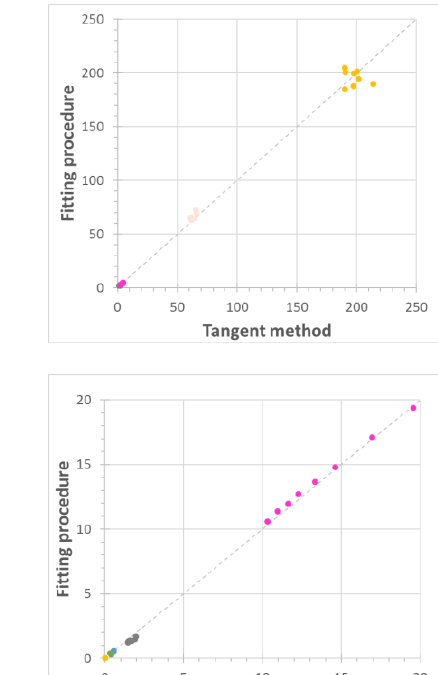
Comesaña ‐ Gándara, B.; Chen, J.; Bezzu, C.G.; Carta, M.; Rose, I.; Ferrari, M.C.; Esposito, E.; Fuoco, A.; using a series of ultrapermeable benzotriptycene ‐ based polymers of intrinsic microporosity. Energy